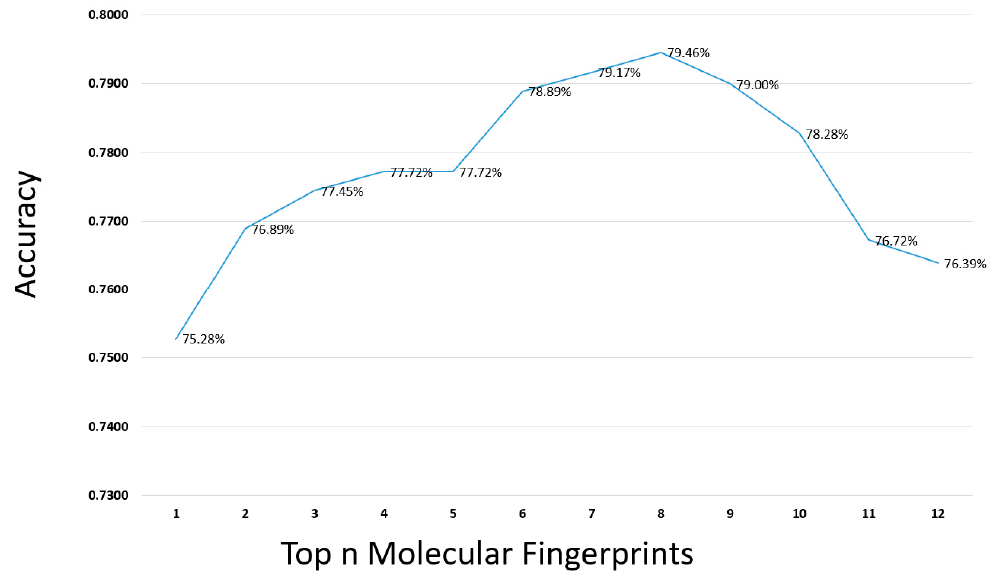
Figure 2. The selection of top n molecular fingerprints from the 12 molecular fingerprints by top 5 classifier.